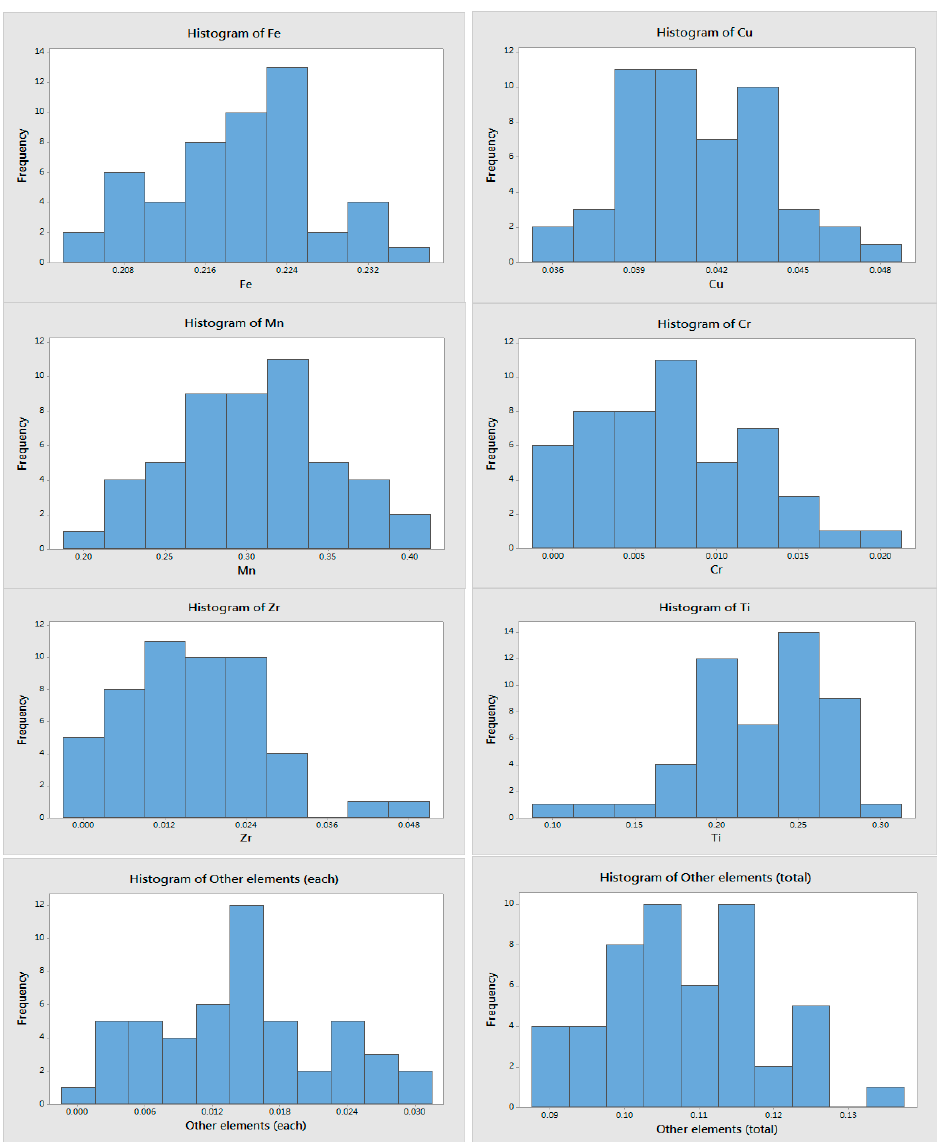
Figure 4. Histograms for each quality characteristic of the adjusted 6063 aluminum alloy rods. Metals 2020 , 10 , x FOR PEER REVIEW